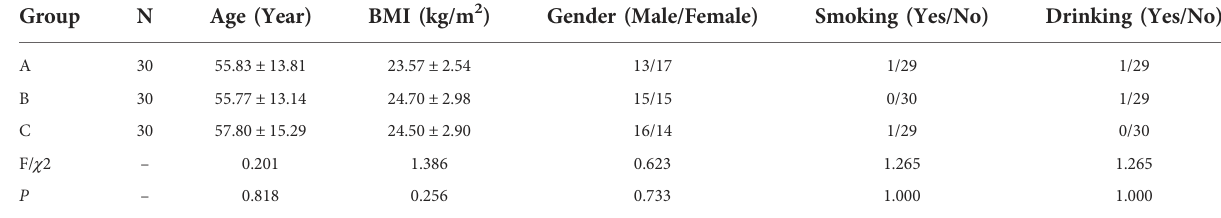
TABLE 1 Basic data of the three groups.